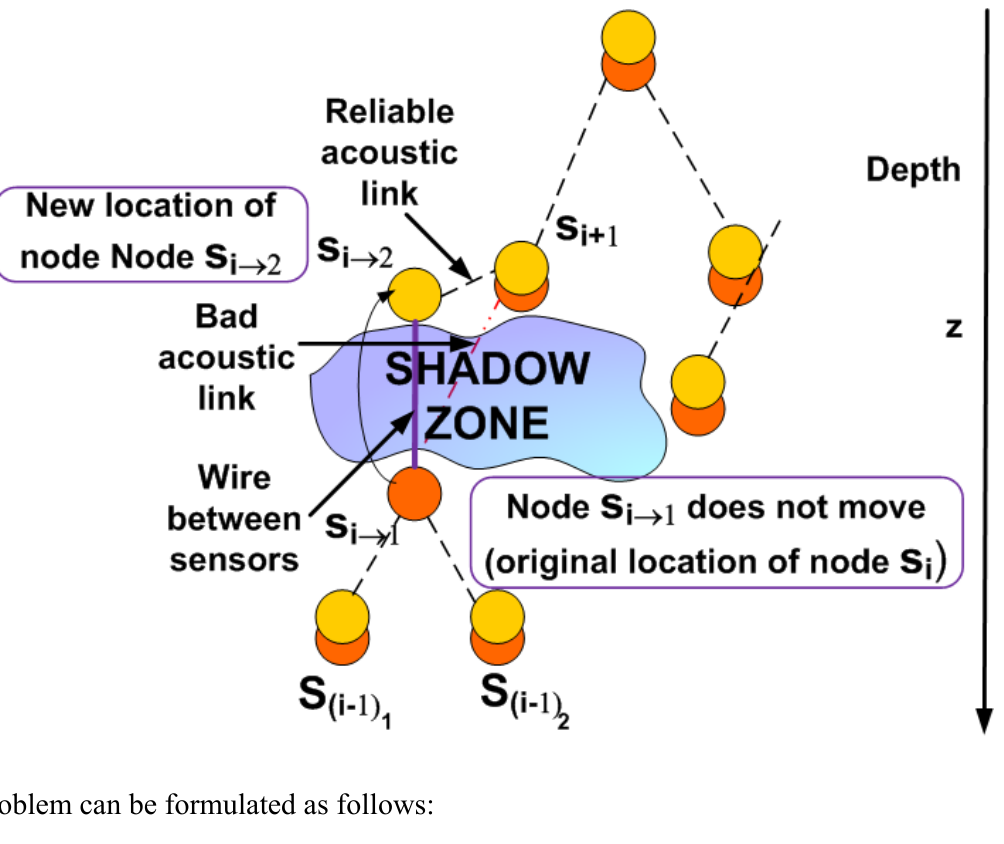
Figure 3. Scenario in the 3D UWSN with a shadow zone (Case